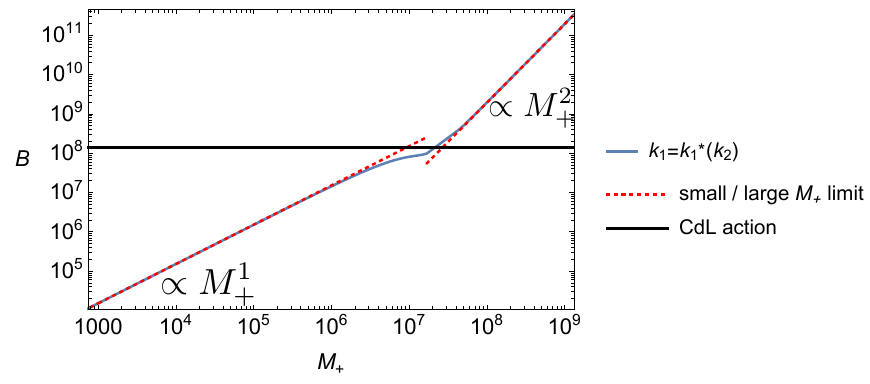
Figure 2 . The bounce action dependence on initial BH mass M l = 9 : 36 10 10 which corresponds to the potential parameters (eq. (2.48)) m = 4 : 08 (cid:2) g = 2 : 13, (cid:21) = 1. The blue line represents the bounce action obtained from the condition k 1 = k (cid:3) (eq. (2.35)), and the red dotted lines the asymptotic forms given by eqs. (2.40) and (2.43). Black solid line means the CDL bounce action given by eq. (2.47). The bounce action of the O (3) bubble become signi(cid:12)cantly smaller than the CDL’s one as M +